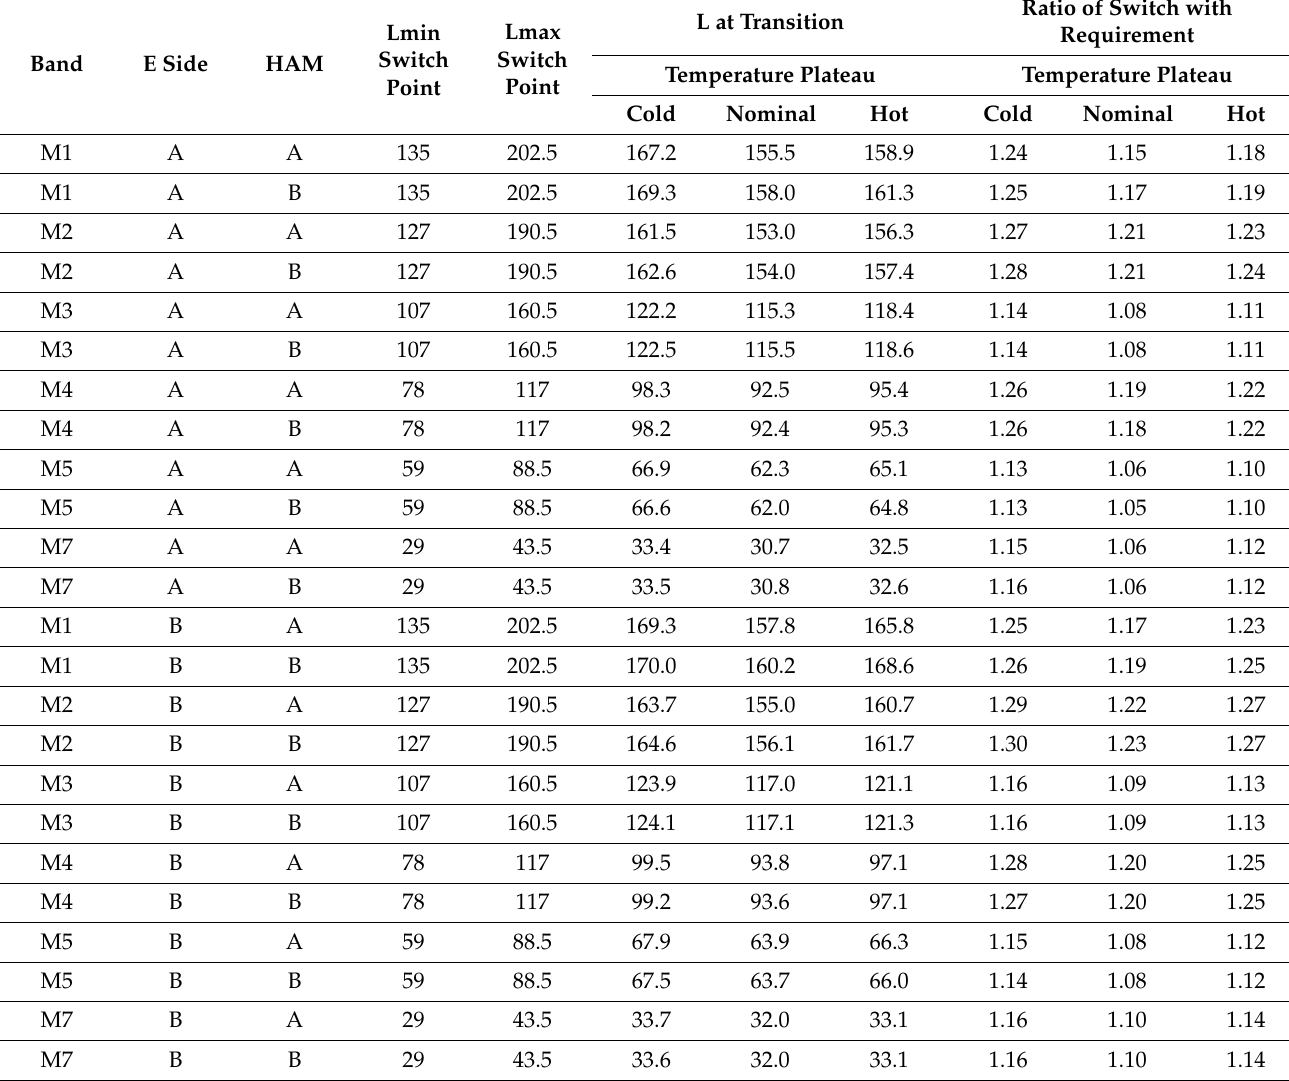
Table 3. VNIR dual gain switch point performance for each HAM and electronics side. The minimum (Lmin) and maximum (Lmax) switch point radiance levels are listed along with the measured transition radiance (L at Transition). The red shows the bands that exceeded the